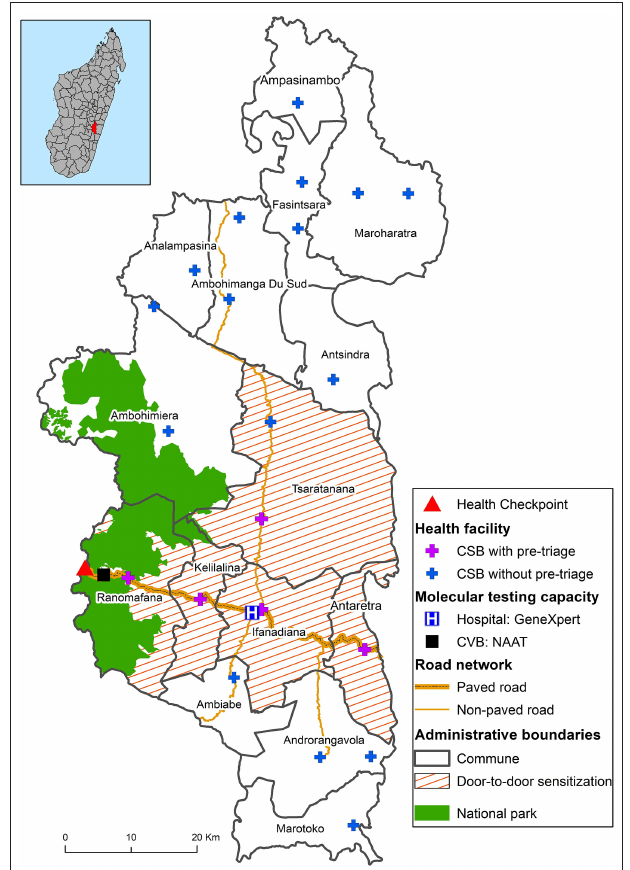
FIGURE 3 | Map of the COVID-19 response in Ifanadiana District with interventions, clinical care, testing capacity, and research activities across levels of the health